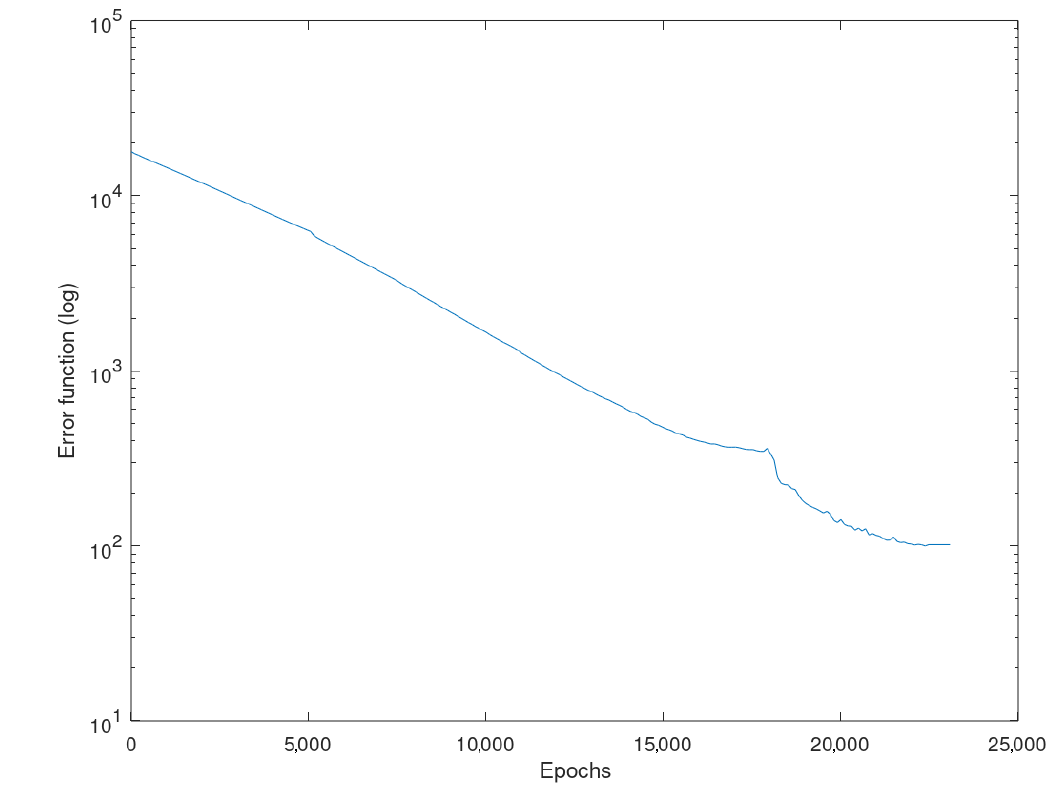
Figure A2. Error function averaged evolution curve for the training on the yield strength data (logarithmic